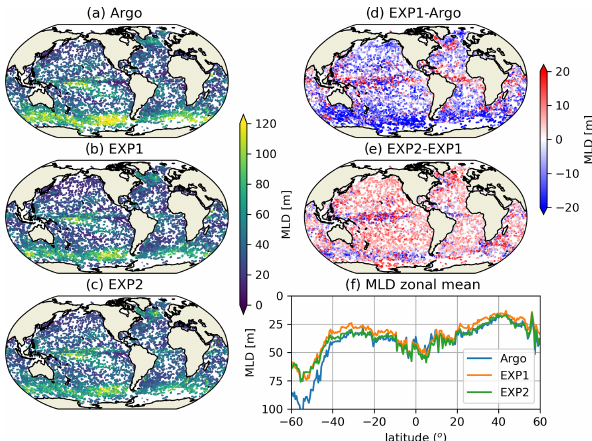
Figure 11. Summer (JAS and JFM for the Northern Hemisphere and Southern Hemisphere, respectively) MLD based on Argo observa- tions (a) and EXP1 (b) and EXP2 (c) simulations. The difference in MLD between EXP1 and Argo and between EXP2 and EXP1 and the zonal mean MLD are shown in (d) , (e) , and (f) , respectively.